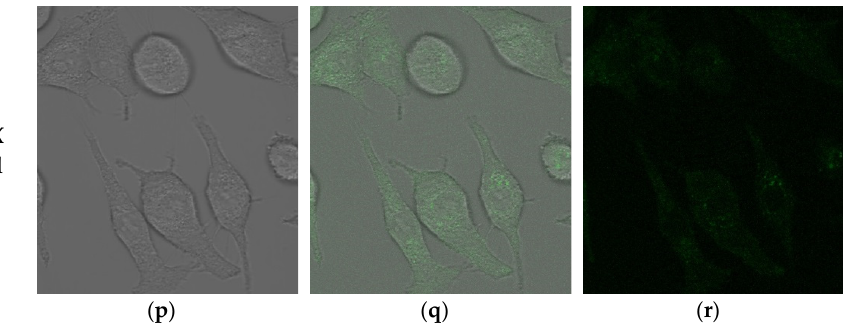
Figure 6. Images of fluorescent signals of calcein AM accumulated in doxorubicin (dox)-resistant A549 cells after treatment with different concentrations of compound 160a for 30 min. ( a – c ): Calcein AM signals of A549 parental cells treated with DMSO; ( d – f ): Calcein AM signals of dox-resistant A549